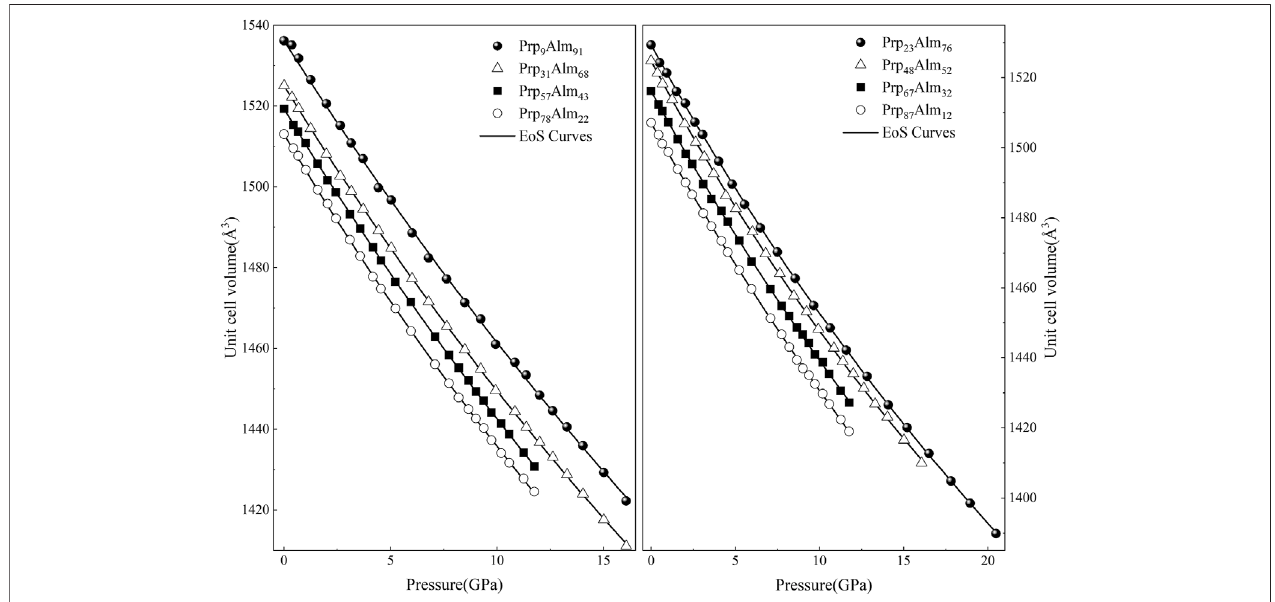
FIGURE 1 | Unit-cell volume compression of pyrope-almandine solid solution garnets at high pressure and room temperature in this study. The error bars of the data points are smaller than the symbols.